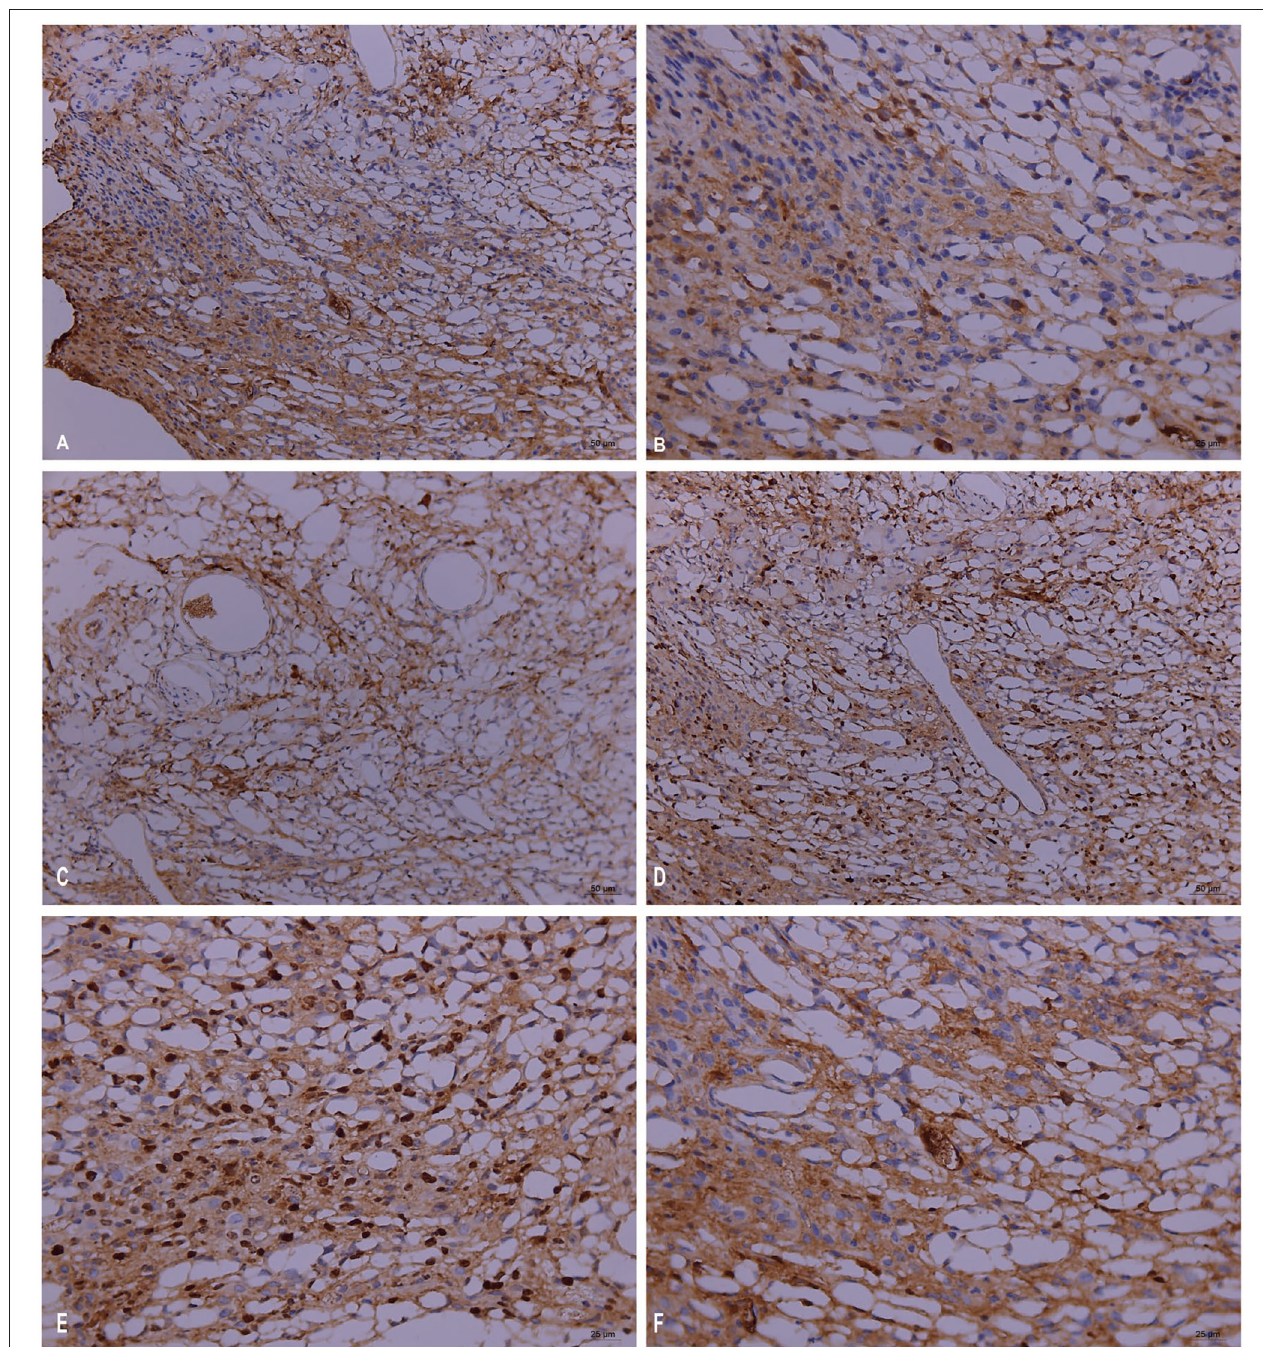
FIGURE 4 | Immunopathology in the mouse models of Trichoderma longibrachiatum (PKUT180420015) from pulmonary spindle cell carcinoma: atypical dysplasia with positive staining of CD3 ε (A) , CD56 (B) , GZMB (C) , Ki67 (D,E) , and PRF (F) by immunohistochemistry.